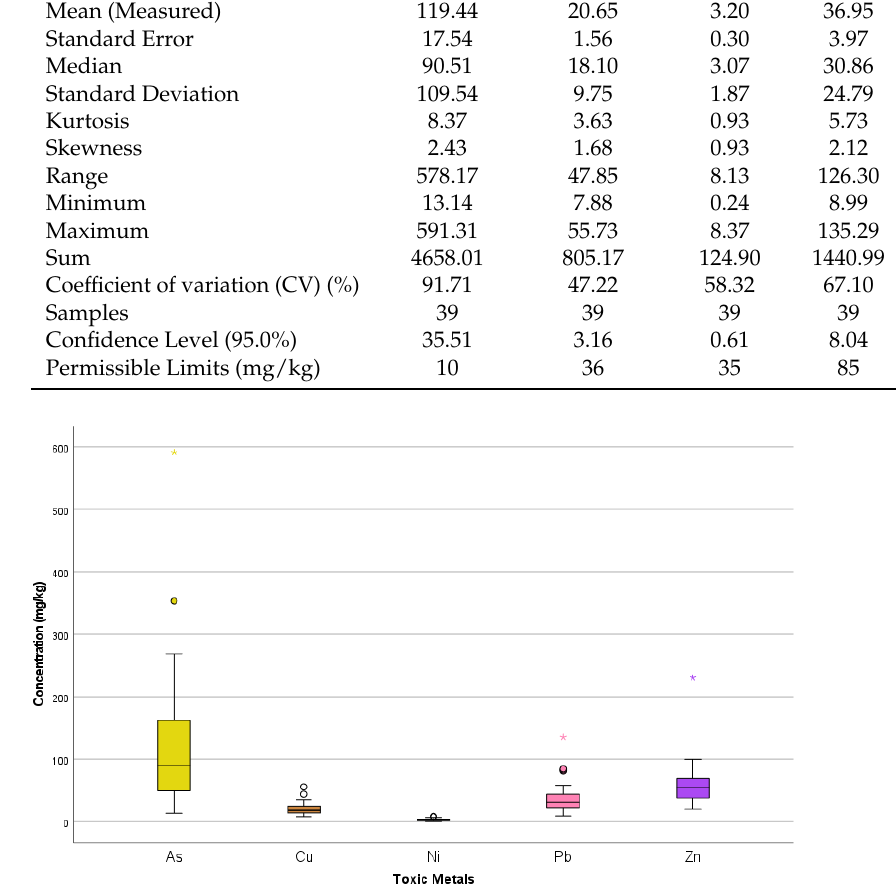
Figure 2. Box and whisker plots showing toxic metal concentrations, with the median at the middle of the box and the lower and upper quartiles at the bottom and top of the